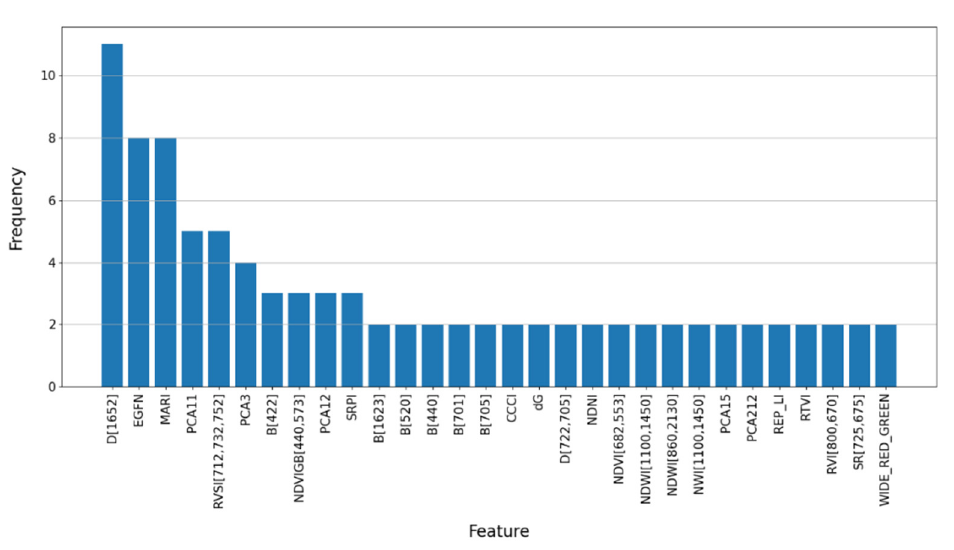
Figure 4. Feature selection frequency by the SFFS.